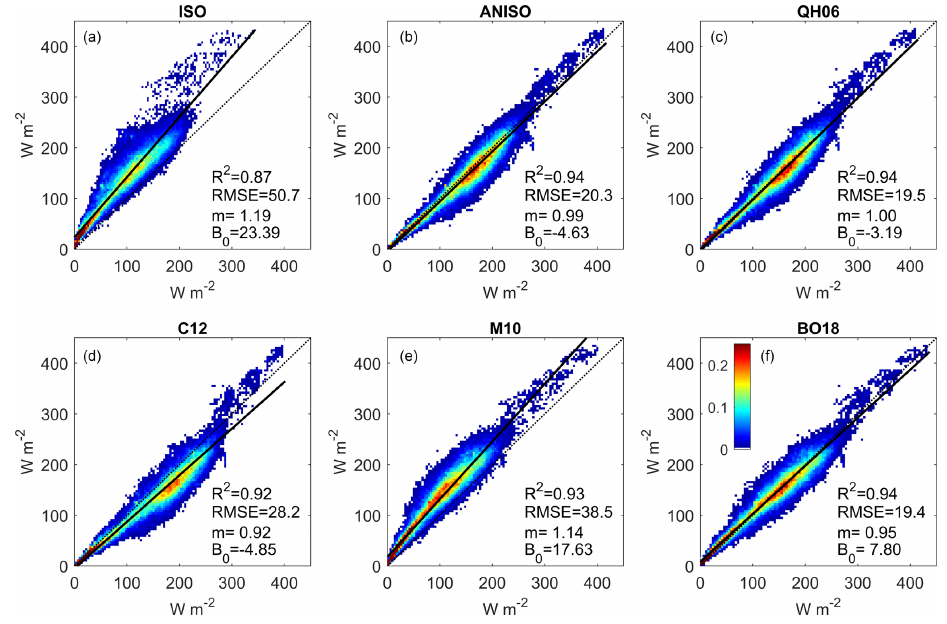
Figure 2. (a–f) Scatter–density regressions of global monthly mean K GCM α ( y axis) and K CERES α ( x axis), with the CERES kernel identifier shown at the top of each subpanel. “ m ”: slope; “ B 0 ”: y intercept. The color scale indicates the percentage of regression points that fall within an averaging bin, where the x axis and y axis have been gridded into 100 × 100 equally spaced bins to help illustrate the density of overlapping points.